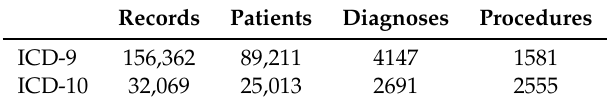
Table 1. Numeric description of ICD-9 and ICD-10 sets.